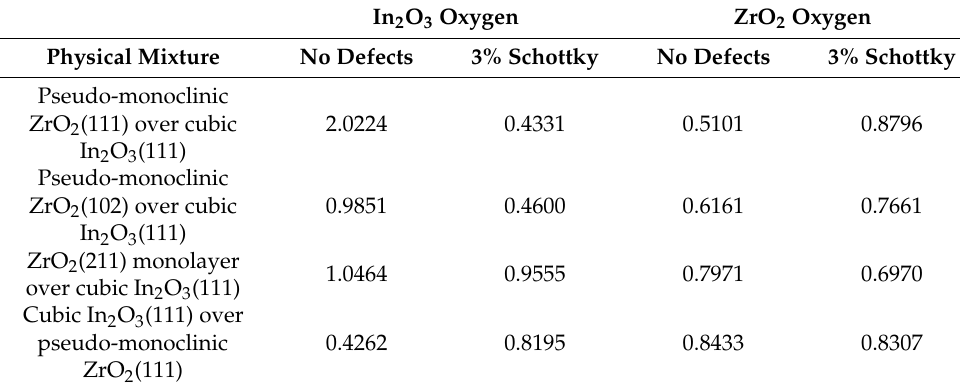
Table 8. Oxygen diffusion activation energy (eV) in physical